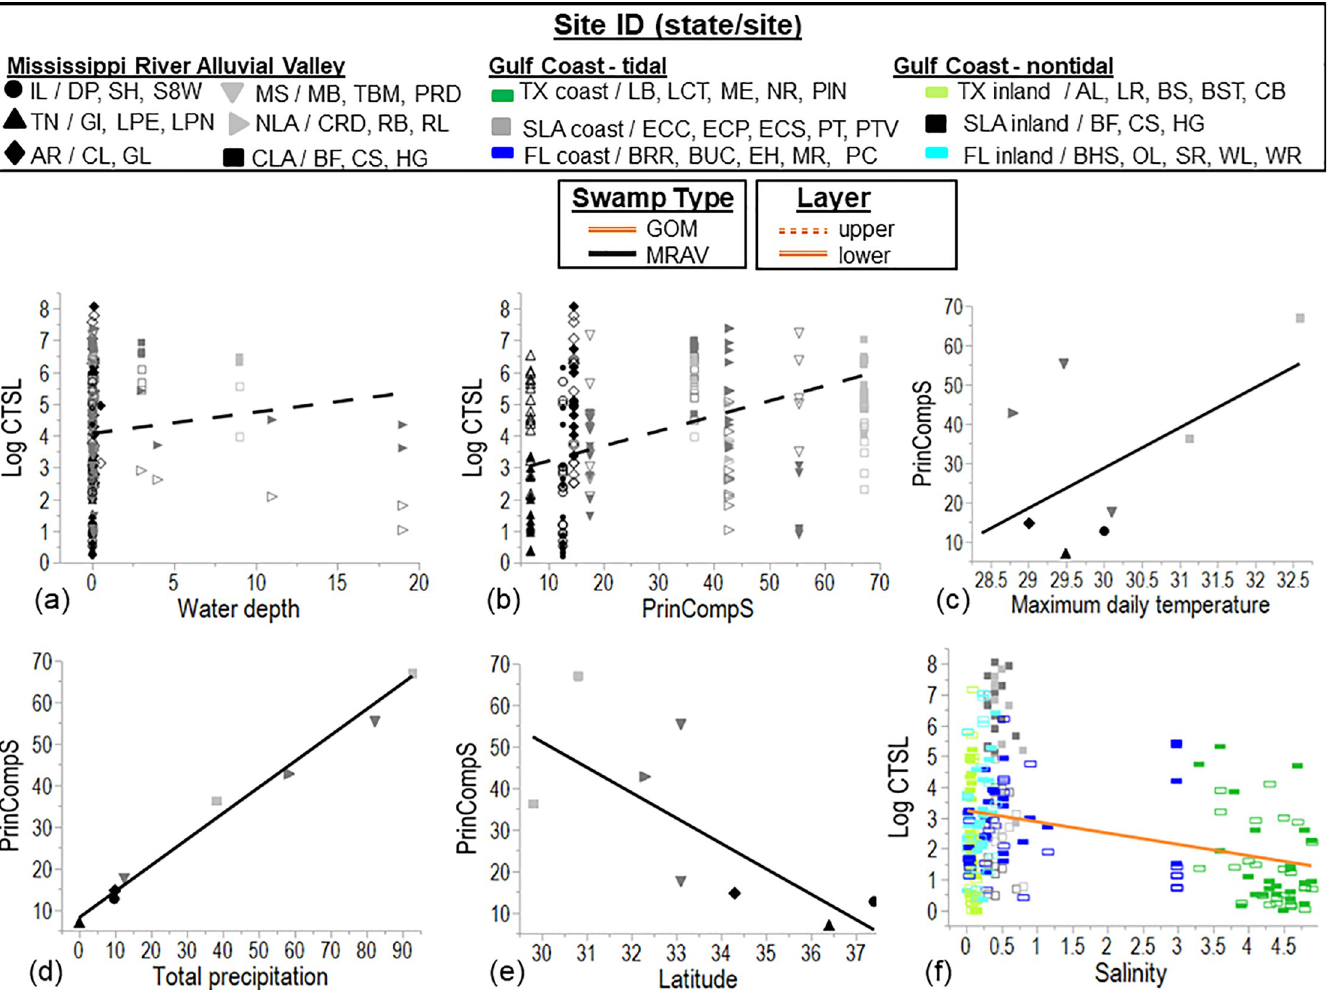
Fig 4. Relationship of cloth decomposition rate (a-e), determined by cotton tensile strength loss (log CTSL day -1 ; 0–10 cm vs. 10–30 cm: upper vs. lower, respectively) with best fit regressions of significant covariables for the Mississippi River Alluvial Valley (MRAV, 2007) including for the upper layer (lower was not significant): (a) PrinCompS, and (b) water depth (cm). The relationship of PrinCompS to (c) maximum daily temperature ( o C), (d) total precipitation during the study (mm), and (e) latitude are given. For the Gulf of Mexico (GOM, 2011), the best fit regressions of significant covariables for both layers were combined (p > 0.05) for (e) salinity (ppt). Whole model fit for MRAV was r 2 = 0.310, F = 16.9, p < 0.0001, and for GOM was r 2 = 0.330, F = 28.3, p < 0.0001. PrinCompS = (mean maximum temperature � 0.567816) + (mean minimum temperature � 0.610242) + (total precipitation � 0.552439)–(mean latitude � 0.511734). Regressions models were prepared only for those climatic and environmental variables identified as significant by PROC GLMSELECT (p < 0.05; S5